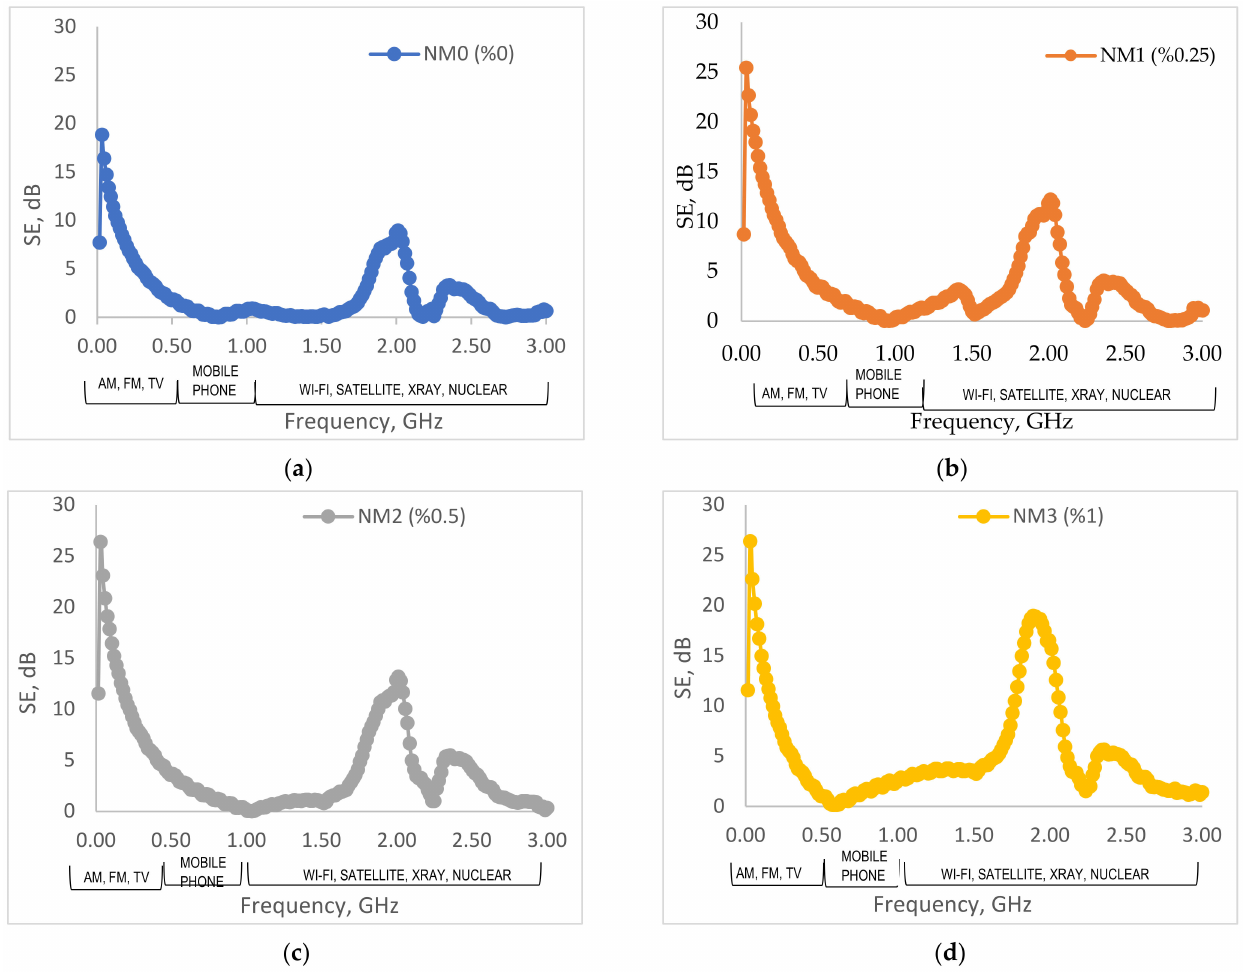
Figure 9. Electromagnetic (EM). ( a ) Reference composite; ( b ) NM1 composite; ( c ) NM2 composite; ( d ) NM3